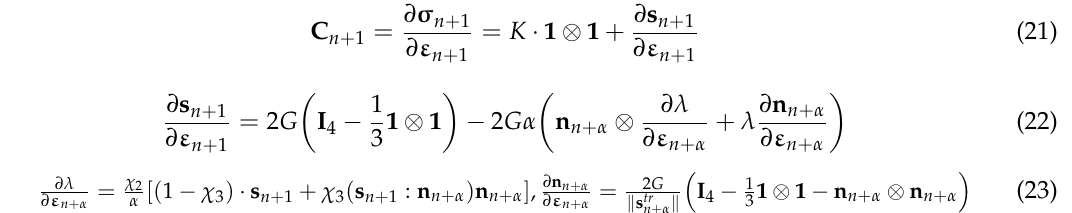
Figure 9. Error leakage in the vicinity of small increment less than 1